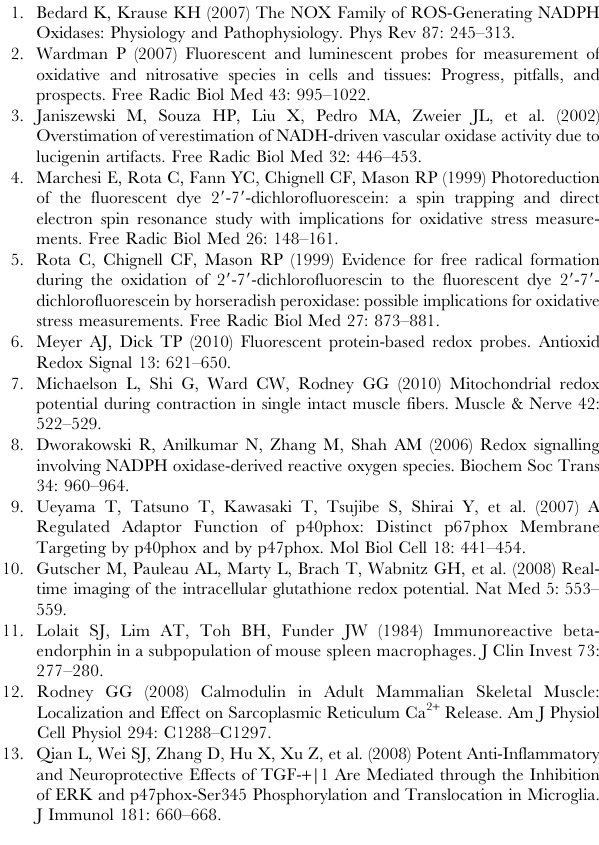
Figure 9. Nox-mediated ROS formation is rescued by p47-roGFP in p47 phox 2 / 2 cells. (A) Macrophage cells from p47 phox 2 / 2 mice transiently transfected with p47 phox - showed homogeneous cytosolic distribution of p47-roGFP in the absence of LPS-mediated activation (left). Cells incubated with LPS (20 ng/ml, 45 min, right) showed p47-roGFP localization with the membrane dye FM4-64 H around the periphery of the cell. (B) LPS stimulation of primary macrophages resulted in rapid oxidation of p47-roGFP in wild-type macrophages (WT, black squares). p47 phox 2 / 2 cells showed a very similar level of p47-roGFP oxidation, but with a slower rate (blue squares). In the absence of LPS-stimulation, wild-type cells showed almost no change in oxidation of p47-roGFP sensor (green square). (C) Average data from (B) before addition of LPS ( 2 LPS) and during the last 3 minutes of LPS stimulation ( + LPS). (D) Tetanic electrical stimulation of single FDBs from wild-type and p47 phox 2 / 2 mice expressing p47-roGFP resulted in similar levels of p47-roGFP oxidation compared to WT. Representative images ( A ) are shown from at least 9 cells. Data (B–C) are representative of n animals =8 per strain, 3 cells per animal and for ( E ) n animals =4 per strain, 3 cells per animal. ** p , 0.01 (Tukey statistical analysis for p